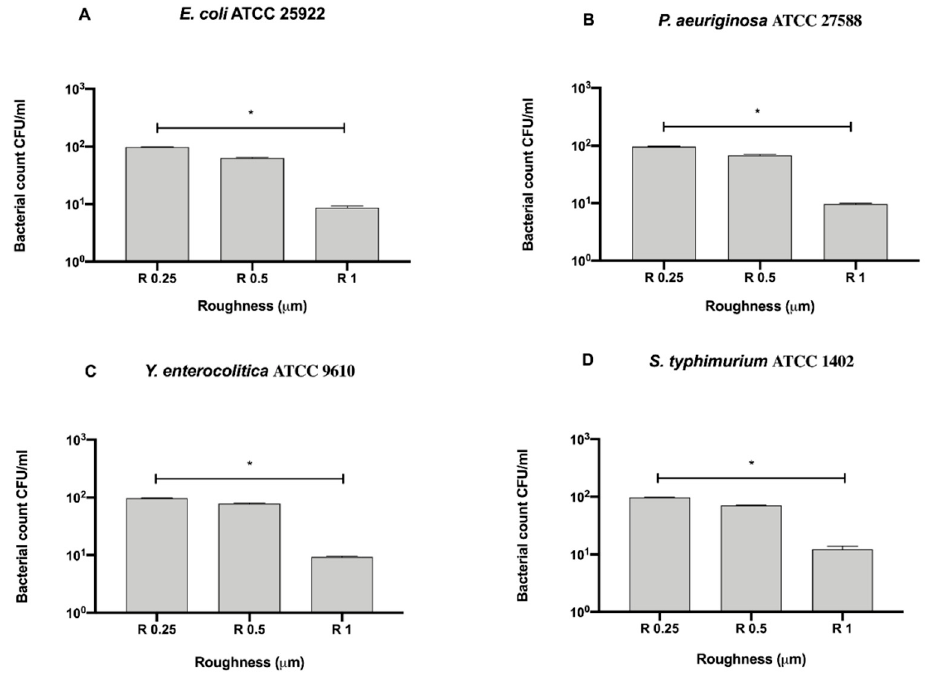
Figure 8. Antibacterial activity of different surface roughness on DURALTI ® ‐ treated disks against Gram-negative bacteria ( A ) E. coli ATCC 25922, ( B ) P. aeruginosa ATCC 27588, ( C ) Y. enterocolitica ATCC 9610 and ( D ) S. typhimurium ATCC 1402, * p < 0.05.